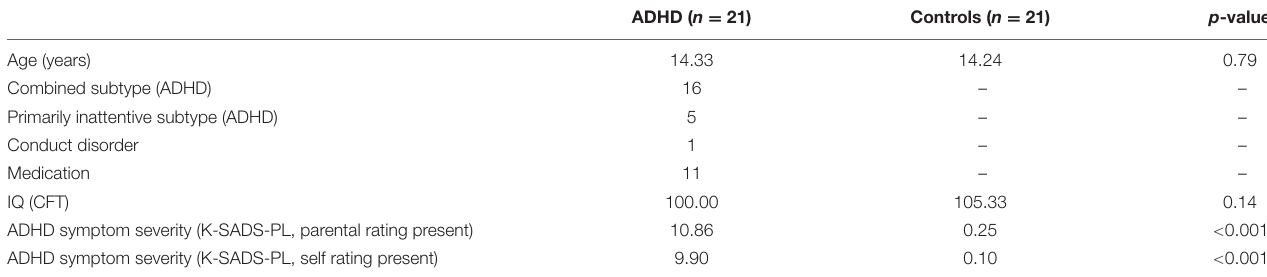
TABLE 1 | Group characteristics.